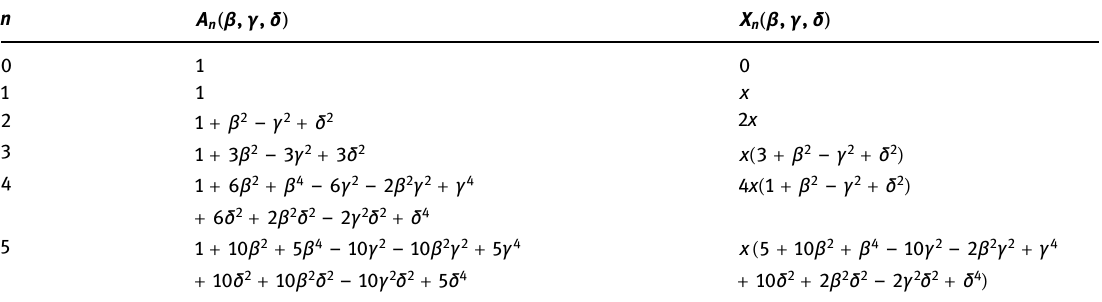
Table 1: Table of Split Quaternaccis for n 5 ⩽ , x